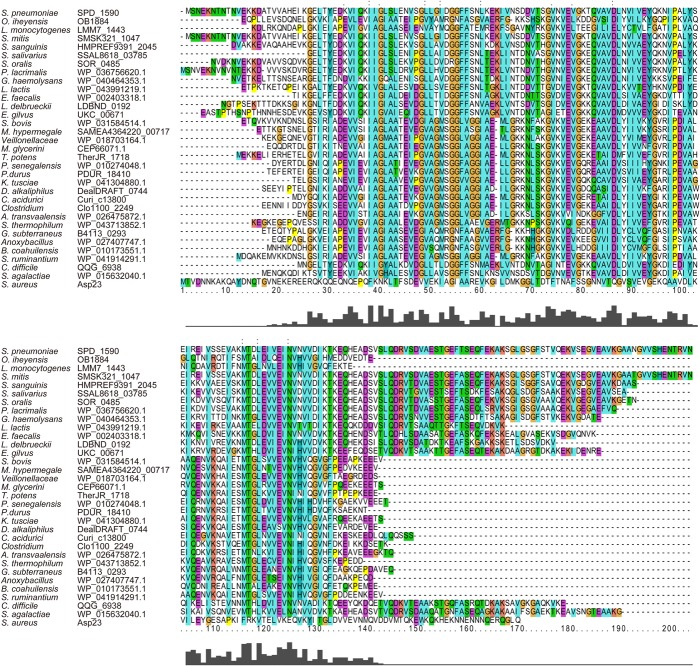
The multiple sequence alignment of SPD_1590 with homologous proteins in the various bacterial species.